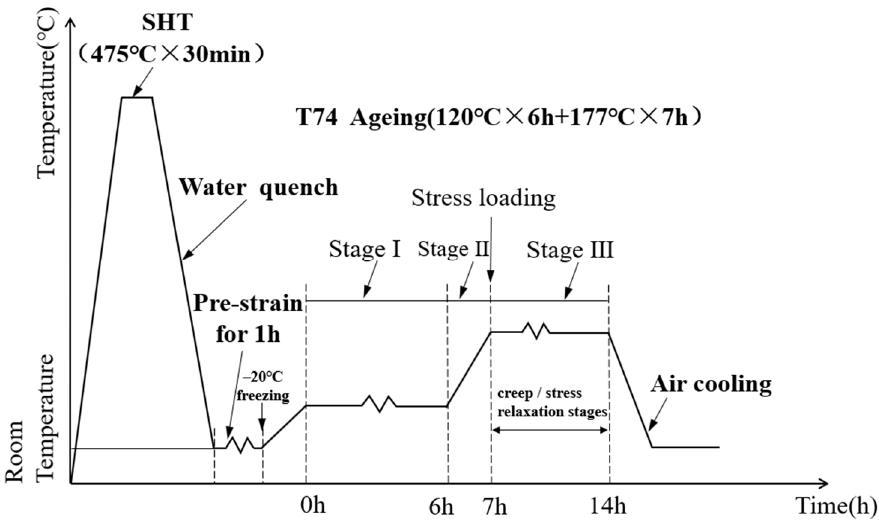
Figure 2. The schematic illustration of the temperature profile for the proposed single-stage creep and stress relaxation tests of 7050 aluminum alloy.